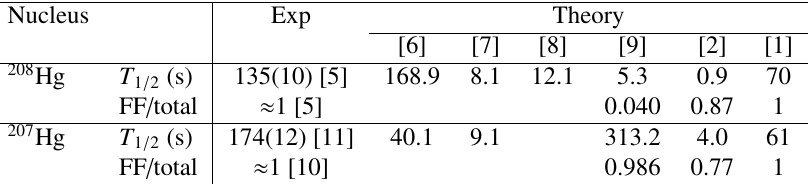
Table 1. Experimentally determined lifetime and first-forbidden beta decay contribution for the β decays of 208 Hg and 207 Hg, compared with theoretical